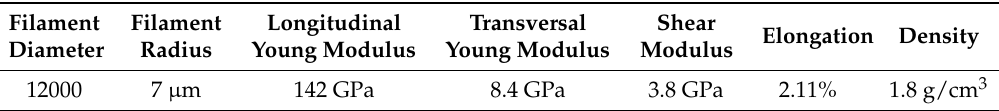
Table 1. The performance parameters of T700 carbon fiber.